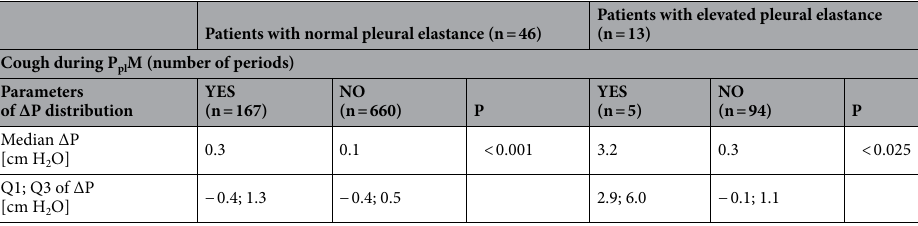
Table 3. The effect of cough during measurement periods on the ΔP distributions in patients with normal and elevated pleural elastance. n—number of patients; ∆P—the difference between the end-expiratory P pl values at the end and beginning of a period; Q1 and Q3—the first and third quartile, respectively; Two sample Kolmogorov–Smirnov test was used to assess statistical significance of differences between ΔP distributions in periods with and without